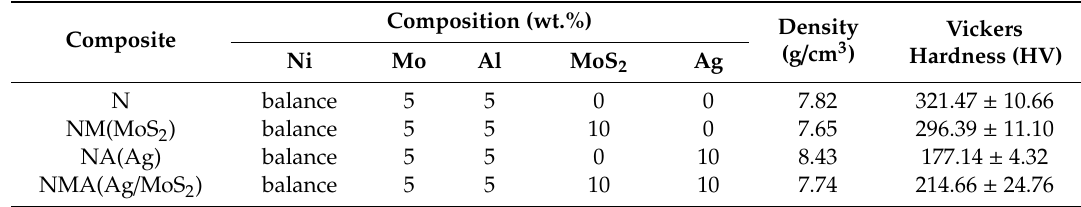
Table 1. Compositions of composites and resulting densities and